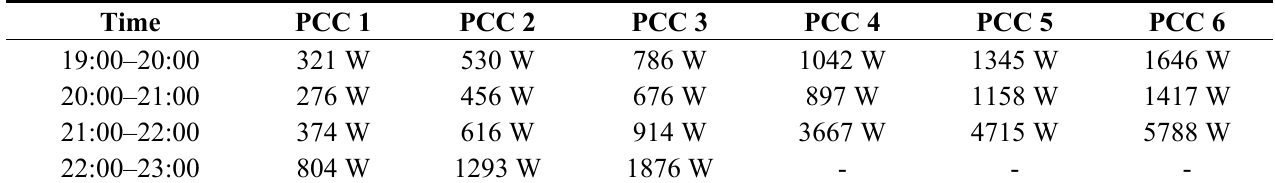
Table 7. ESS optimally discharging schedule for voltage